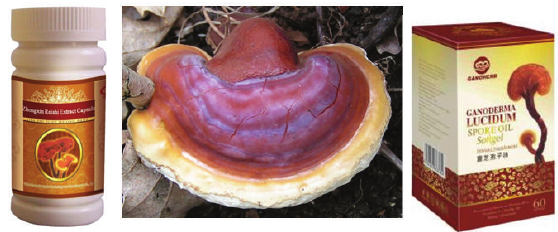
Figure 4: Ganoderma the “mushroom of immortality.”